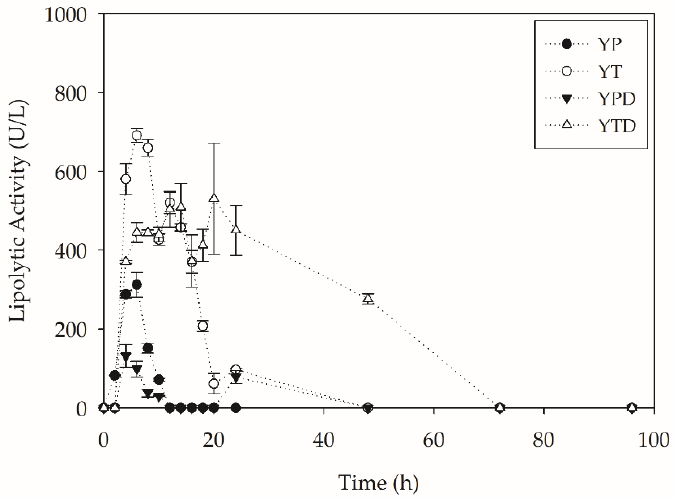
Figure 3 . Lipolytic activity during PC-PET biodepolymerization by submerged cultures of Y. lipo- lytica IMUFRJ 50682 at 28 °C and 250 rpm for 96 h. IMUFRJ 50682 at 28 ◦ C and 250 rpm for 96 h.